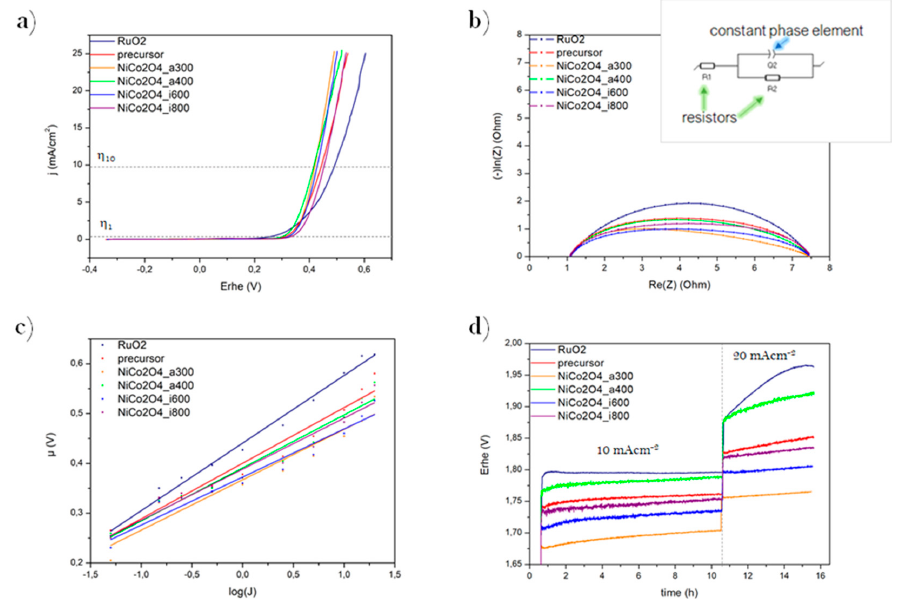
Figure 3. OER electrochemical measurements: LSV plots ( a ), Nyquist plots (with an inset graph window of equivalent Circuit R1R2Q) ( b ), Tafel plots ( c ), and chronopotentiometry plots ( d ) of the obtained materials compared to RuO 2 .